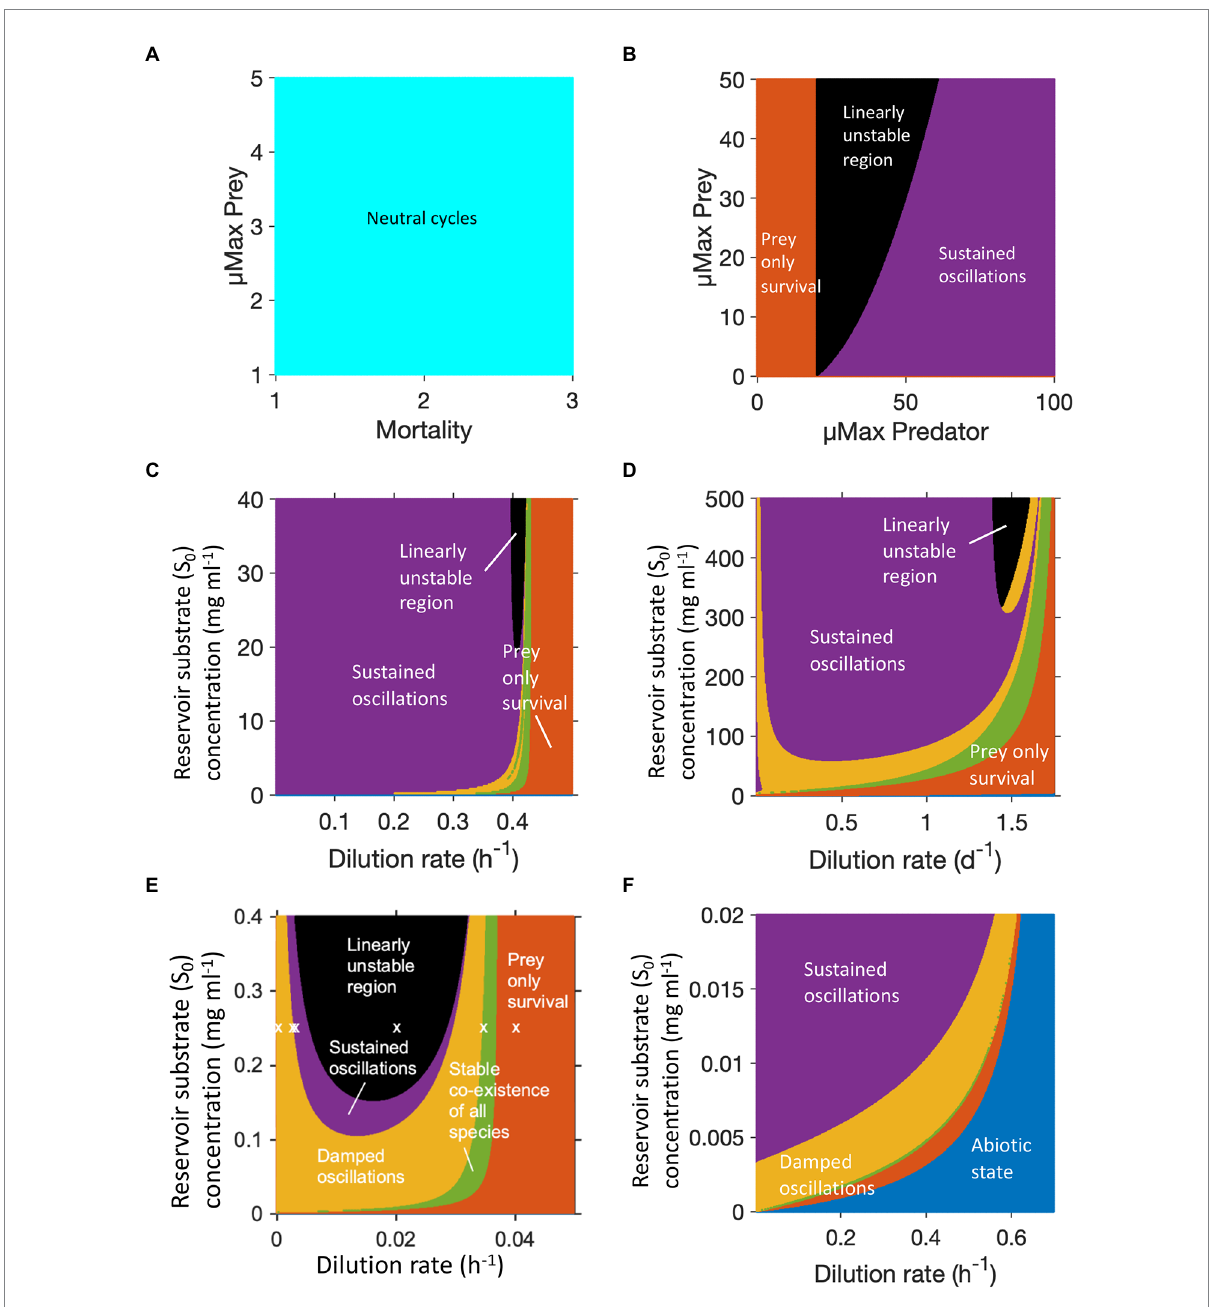
FIGURE 2 Dynamic regimes generated by different predator prey models, each color represents a different regime. (A) Lotka-Volterra model: only neutral cycles. (B) Lotka-Volterra model altered to have logistic prey growth and a Holling type II predator functional response: stable limit cycles (sustained oscillations), no coexistence without oscillations. (C) Protist predation from (Curds and Bazin, 1977): damped oscillations and coexistence without oscillations possible. (D) Rotifer predation from (Fussmann et al., 2000): similar to (C) with larger region of damped oscillations. (E) B. bacteriovorus predation from (Summers and Kreft, 2021). Copyright © 2022 American Society for Microbiology. Appl. Environ. Microbiol. 88:e01082-21. doi: 10.1128/AEM.01082-21: similar to (C) with even wider region of damped oscillations but also wider linearly unstable region. (F) Bacteriophage predation from (Summers and Kreft, 2021): same model/equations as in (E) but applying phage parameters removes the linearly unstable region. Note we cannot cover the whole feasible parameter space in these